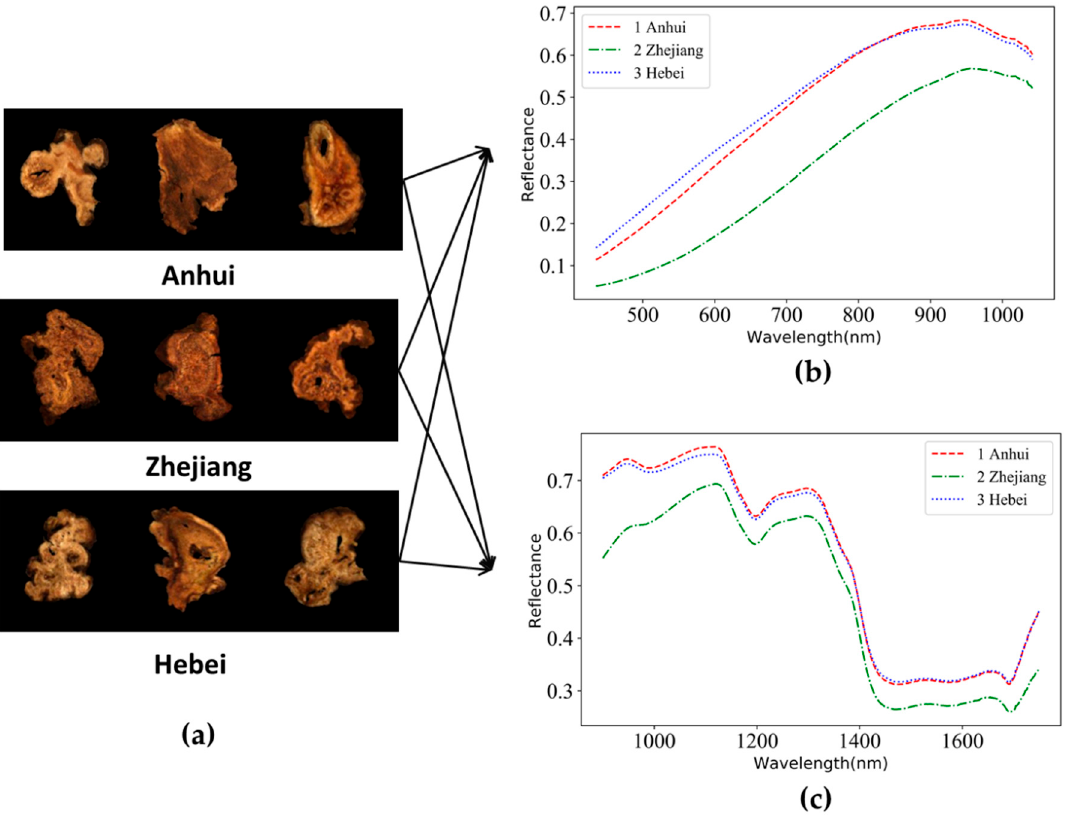
Figure 4. Representative Red-Green-Blue (RGB) images ( a ) and raw spectra of Rhizoma Atractylodis Macrocephalaes (RAMs) in the VNIR range ( b ) and SWIR range ( c ) based on the whole data set.